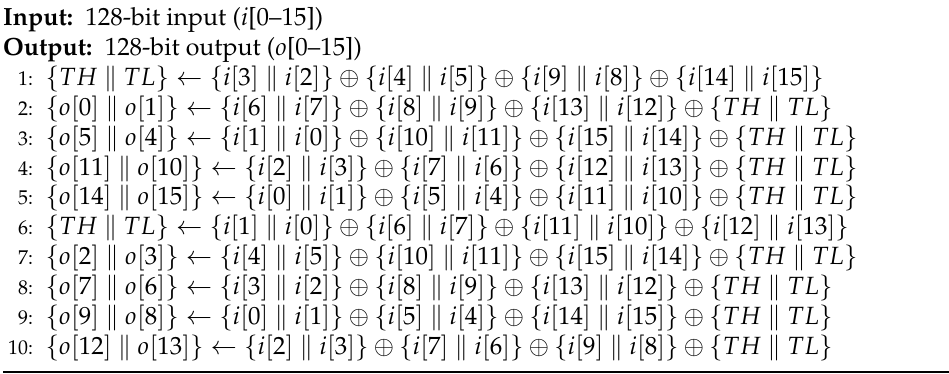
Algorithm 2 The 2-way diffusion layer of ARIA block cipher for the 16-bit MSP430 micro-